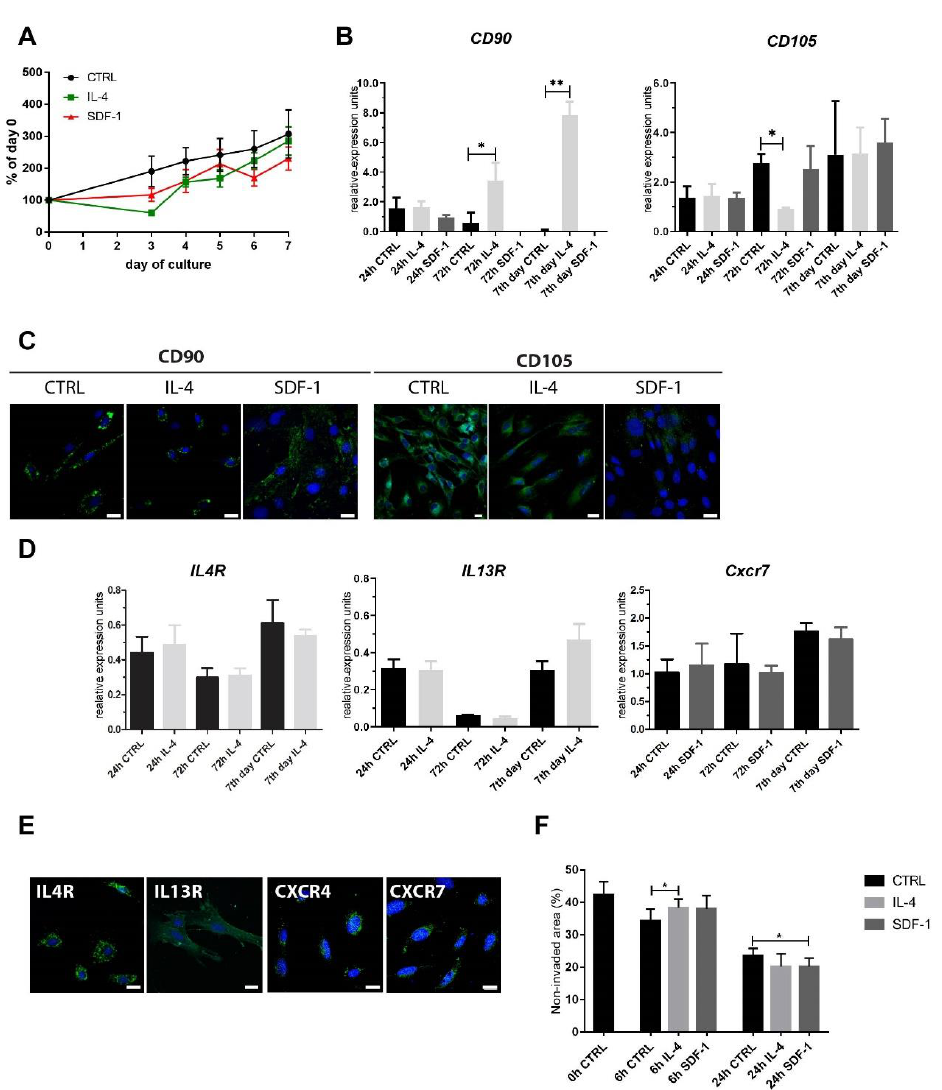
Figure 1. Characterization of mouse adipose tissue-derived stromal cells (mADSCs) cultured under control conditions or in the presence of IL-4 or SDF-1. ( A ) Growth curves of mADSCs cultured for 7 days; data shown as a proportion of the number observed at day 0. ( B ) Analysis of the level of mRNAs encoding CD90 and CD105. Expression was related to the levels observed in control cells at day 0 (beginning of the culture) and normalized to mRNA encoding hypoxanthine phosphoribosyl transferase, i.e., HPRT. ( C ) Localization of CD90 or CD105 (green) and nuclei (blue) in mADSCs after 72 h of culture, bar = 20 µ m. ( D ) Analysis of the level of mRNAs encoding IL4R, IL13R, and CXCR7. Expression was related to the levels observed in control cells at day 0 (beginning of the culture) and normalized to mRNA encoding HPRT. ( E ) Localization of IL4R, IL13R, CXCR7, or CXCR4 (green) and nuclei (blue) in control mADSCs after 7 days of culture, bar = 20 µm. ( F ) In vitro migration assay—mADSCs were scratched from the culture dish and the area which was not invaded by migrating cells was measured and presented as the proportion (%) of the whole area photographed (0 h, 6 h, and 24 h). For each experimental group n ≥ 3. Data are presented as mean ± SD. Data have been analyzed using Student’s t -test ( A ); two-way ANOVA test (d-CXCR7, F ); Kruskal-Wallis test ( B , D —IL4R, IL13R). * p < 0.05; ** p <